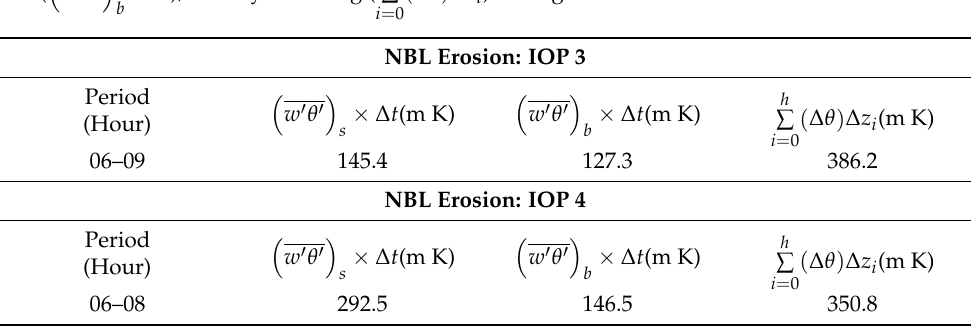
Table 2. Integrated total heat flux for the NBL erosion period at the surface ( (cid:16) (cid:17) ∗ ∆ t ), and layer heating ( w (cid:48) θ (cid:48) flux ( b